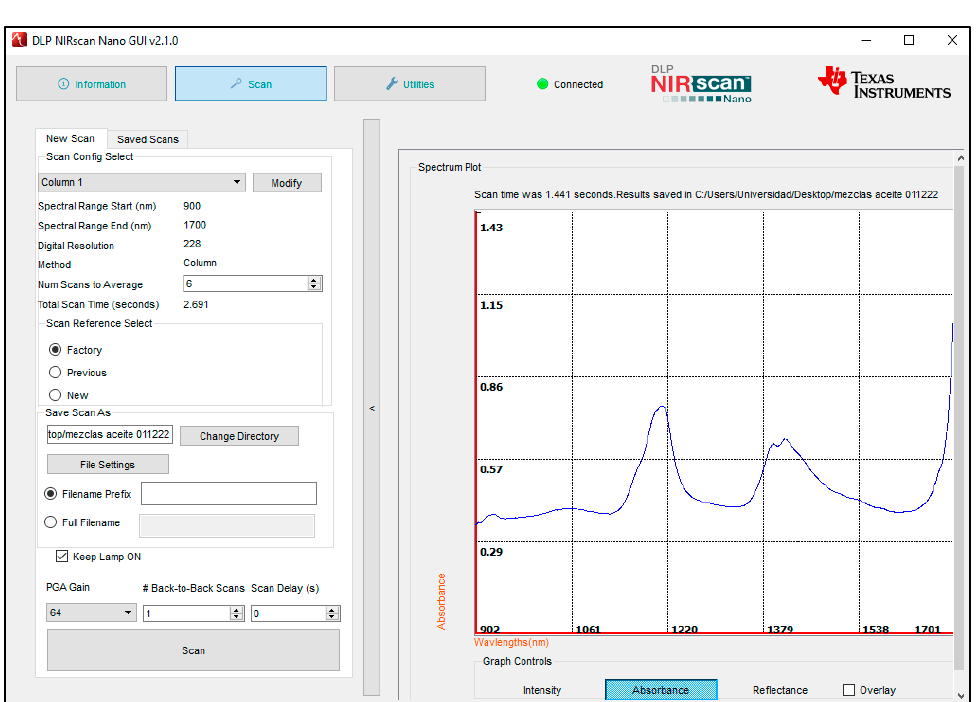
Figure 9. DLP NIRscan Nano GUI Scan Screen.